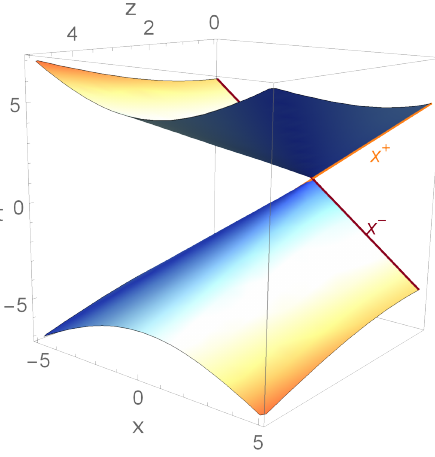
Figure 7 . The support of the shock inside the bulk of AdS, plotted at ~x ⊥ = 0 . The magnitude of the delta function is x − -dependent such that it vanishes (this is displayed in blue) on the lightlike directions x + at the